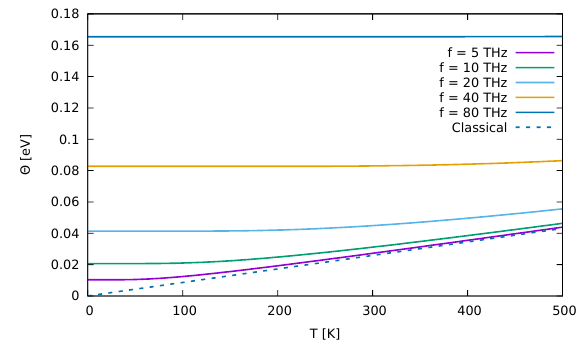
( ! ) (equation (15)) as a function of temperature Figure 7. ⇥ Q T for several frequencies. The classical counterpart k B T , which does not depend on frequency, is also shown (dashed line) for comparison.